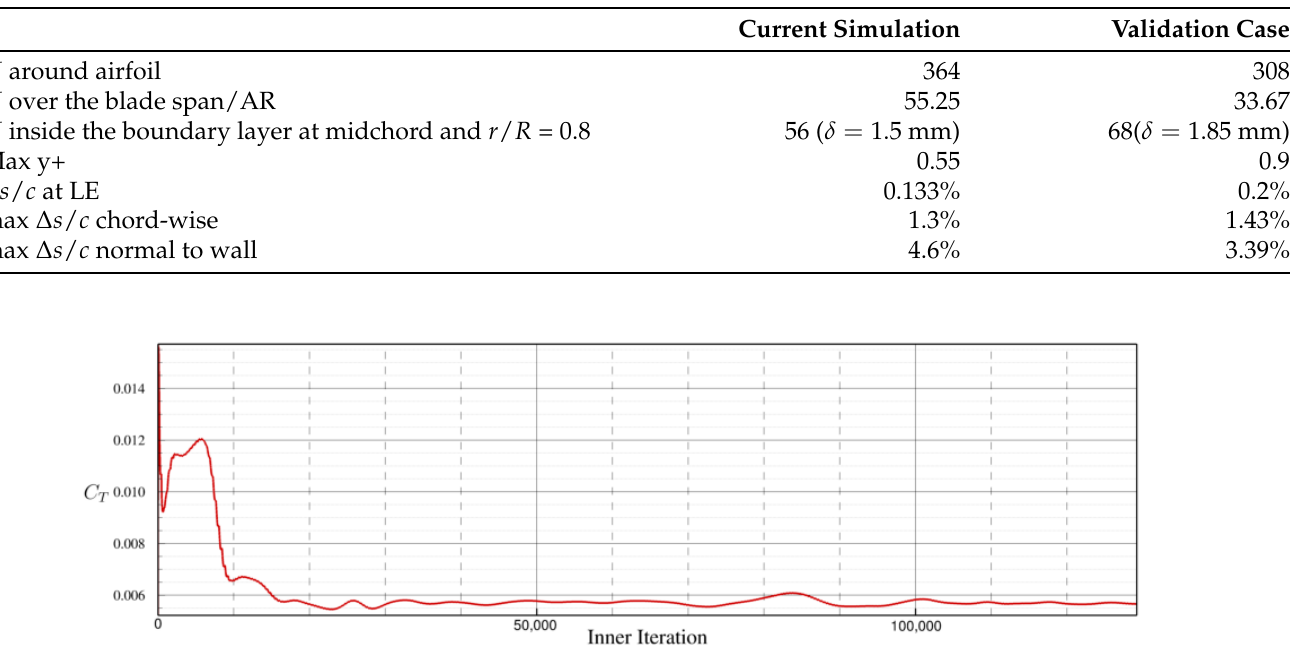
Figure A4. Thrust coefficient along inner